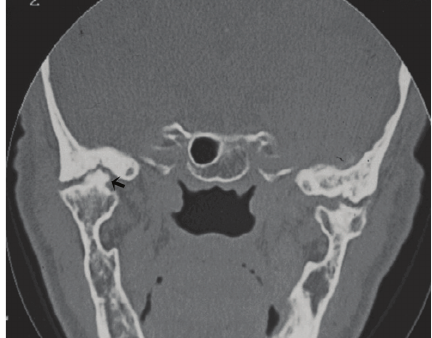
Figure 4: Large bone outgrowth (osteophyte) in the left TMJ (arrow) and bilateral subchondral